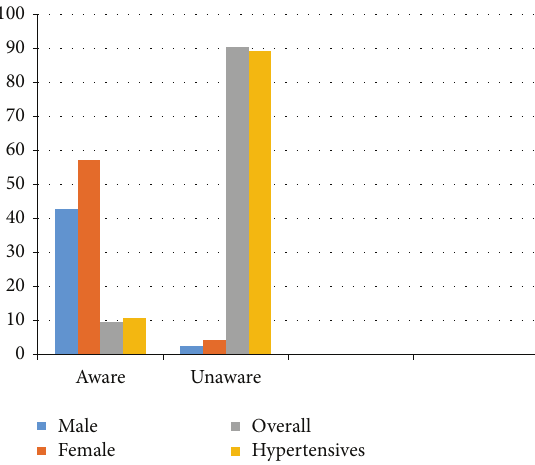
Figure 1: Awareness of Hypertension in